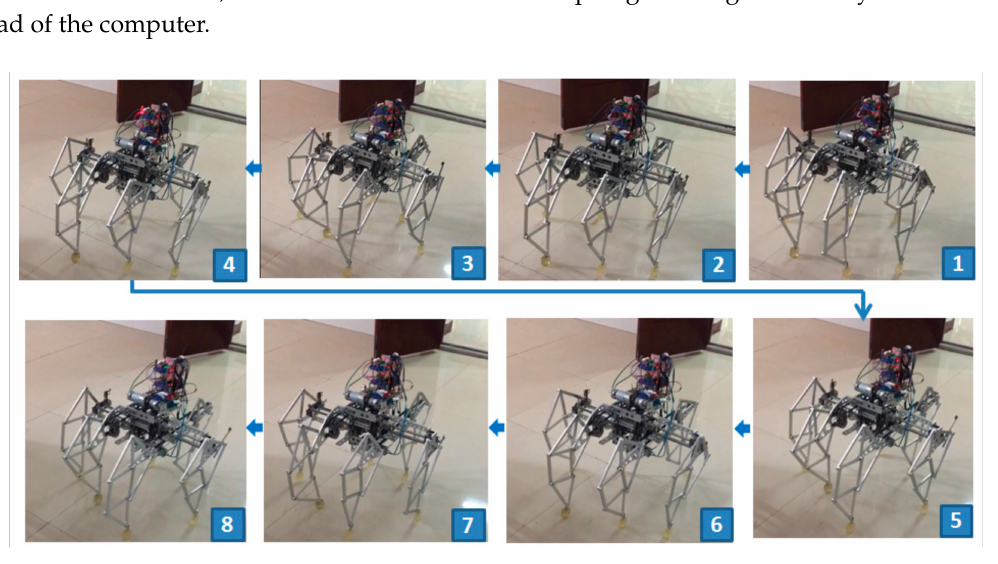
Figure 17. Snapshots of the hexapod robot in